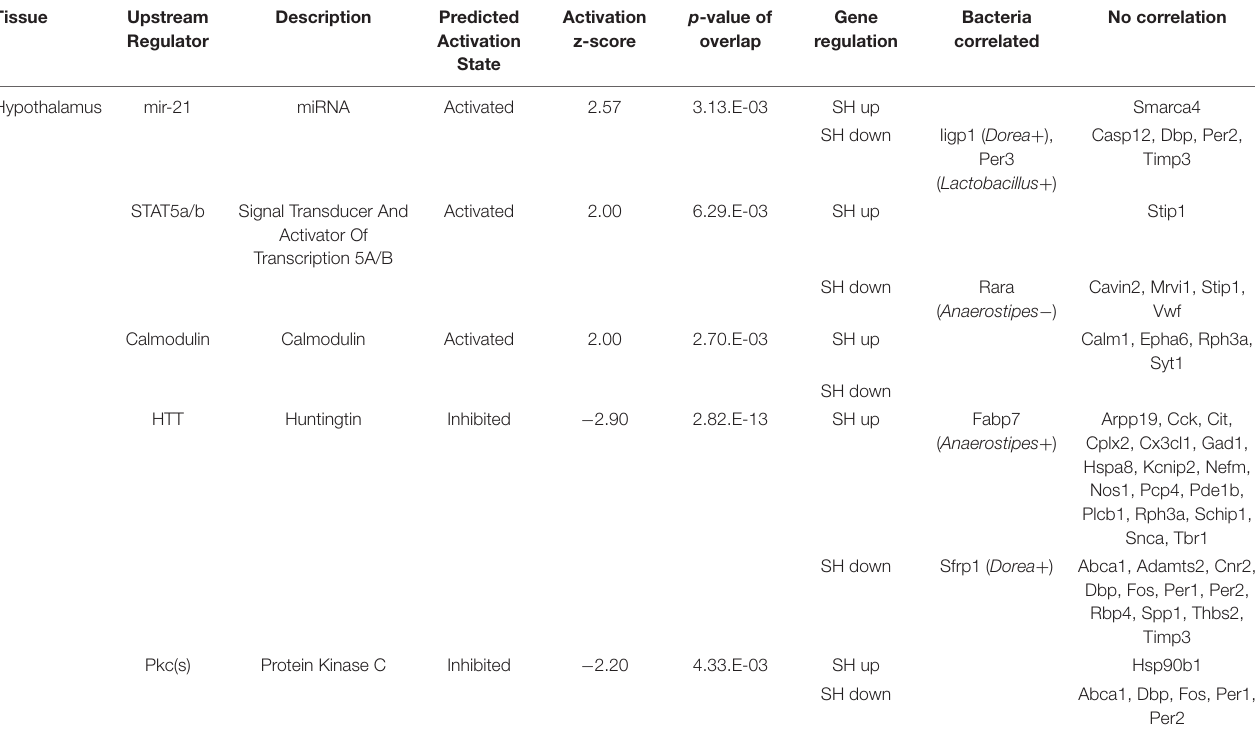
TABLE 2 | The functional enrichment analysis of the genes affected by single housing (SH) condition in the